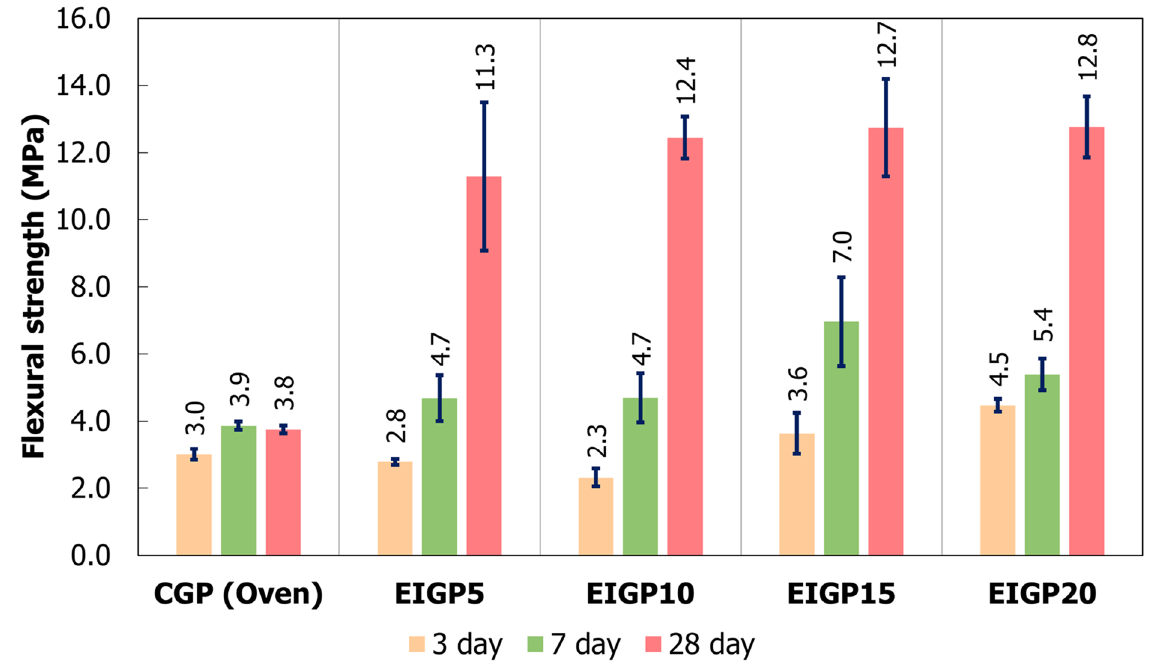
Figure 6. The flexural strength of CGP and EIGP